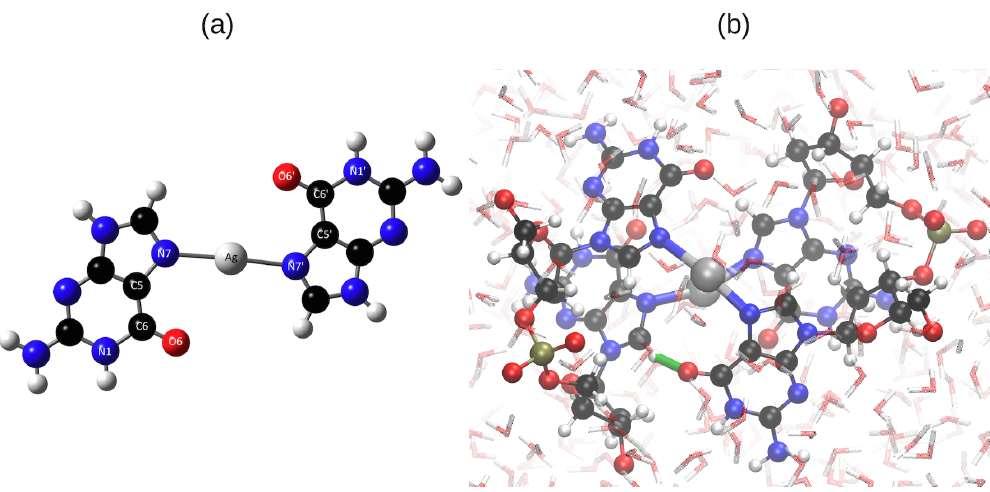
Figure 1. ( a ) Ag + binds to N7 and N7’ in the Hoogsteen region; ( b ) One typical structure of G 2 -Ag + from the final 0.5 ps of the hybrid quantum mechanics/molecular mechanics (QM/MM) simulation. The structure was taken from our previous work [21] and replotted here. The interplanar H-bond is highlighted with a green line. Atomic color code: Ag: silver, N: blue, C: black, O: red, P: Olive and H: